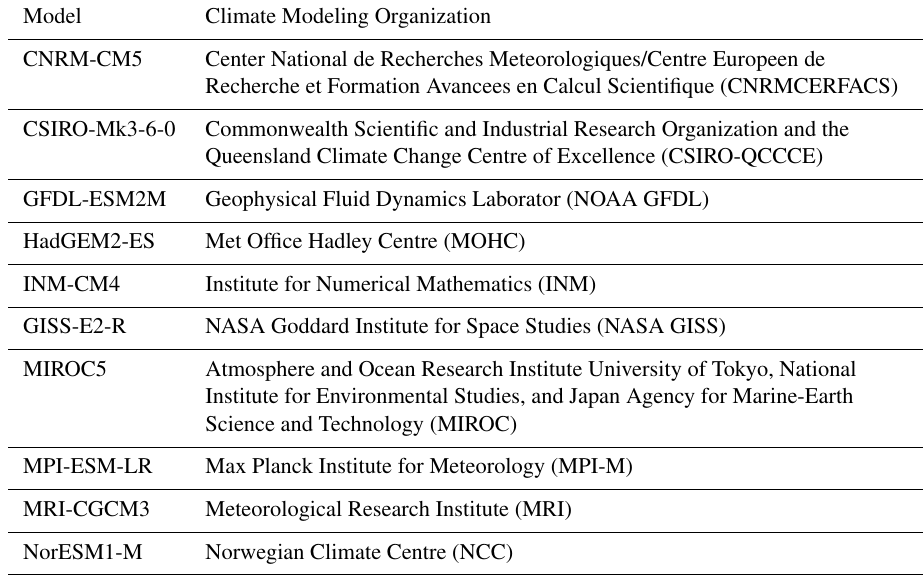
Table 1. List of the 10GCMs used in this study. Model